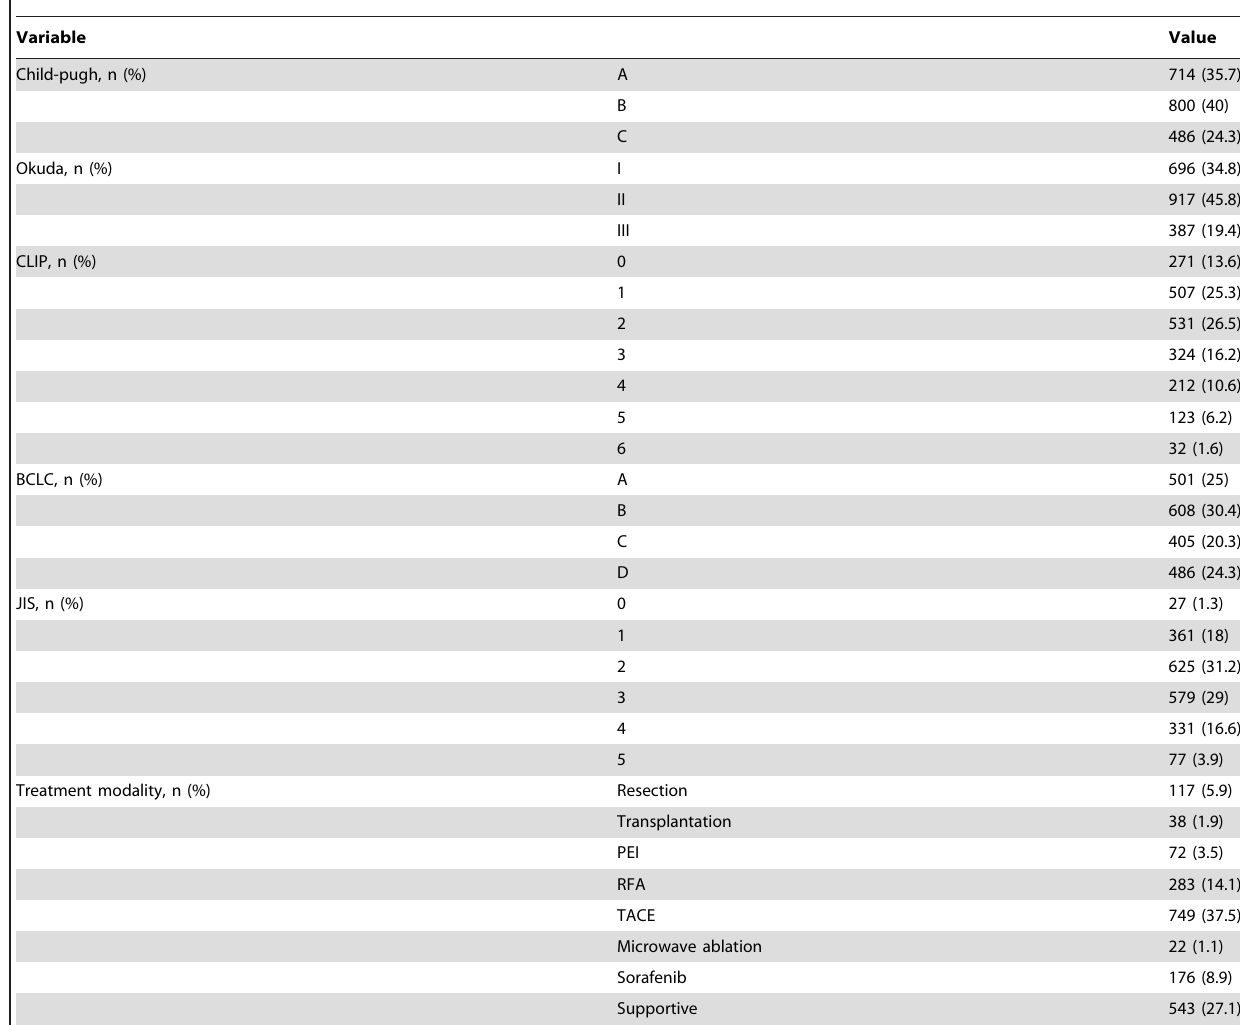
Table 2. Staging by different systems and scores, and treatments